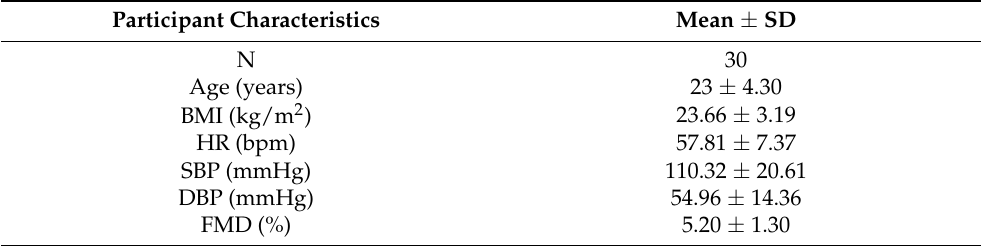
Table 2. Participant baseline